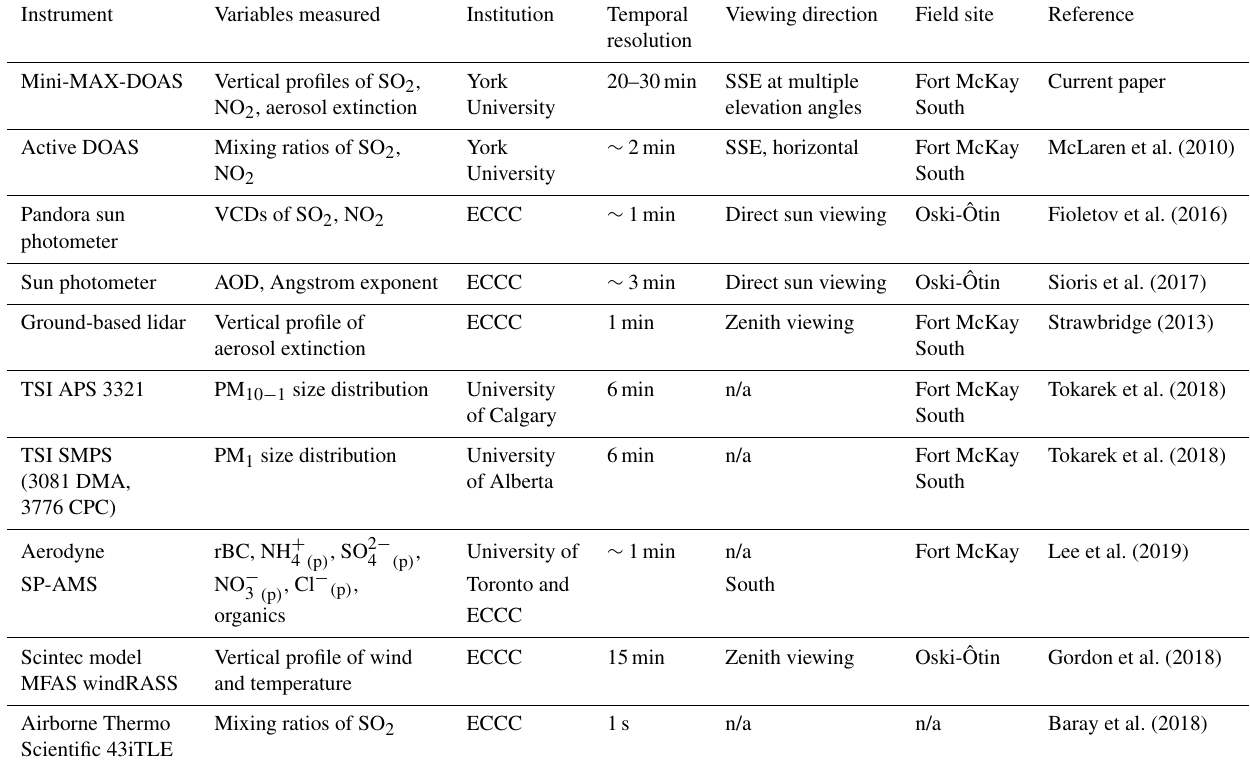
Table 1. Description and locations of the study